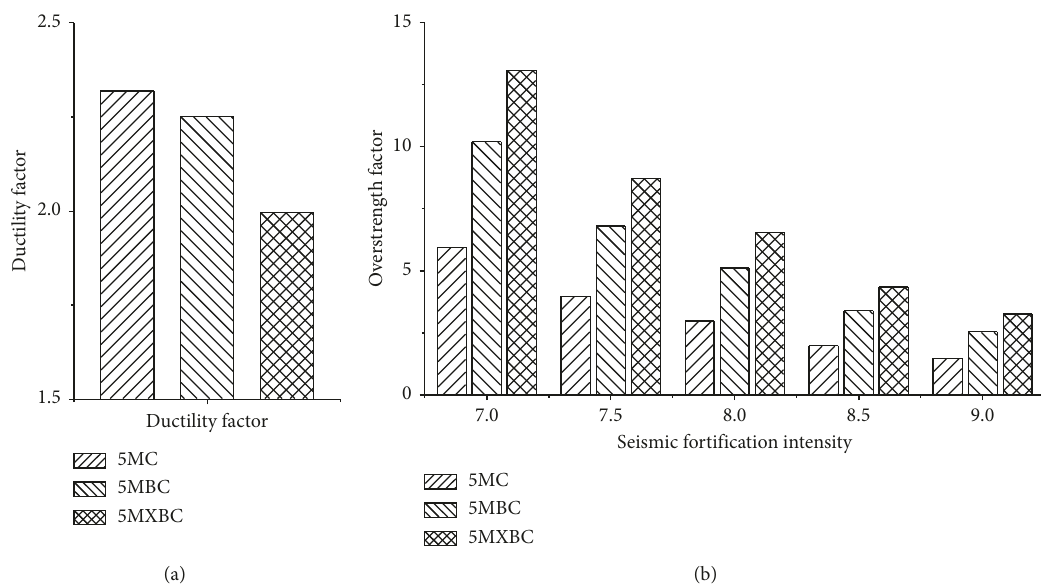
Figure 23: Behavior factors of the model structure: (a) ductility factors; (b) overstrength